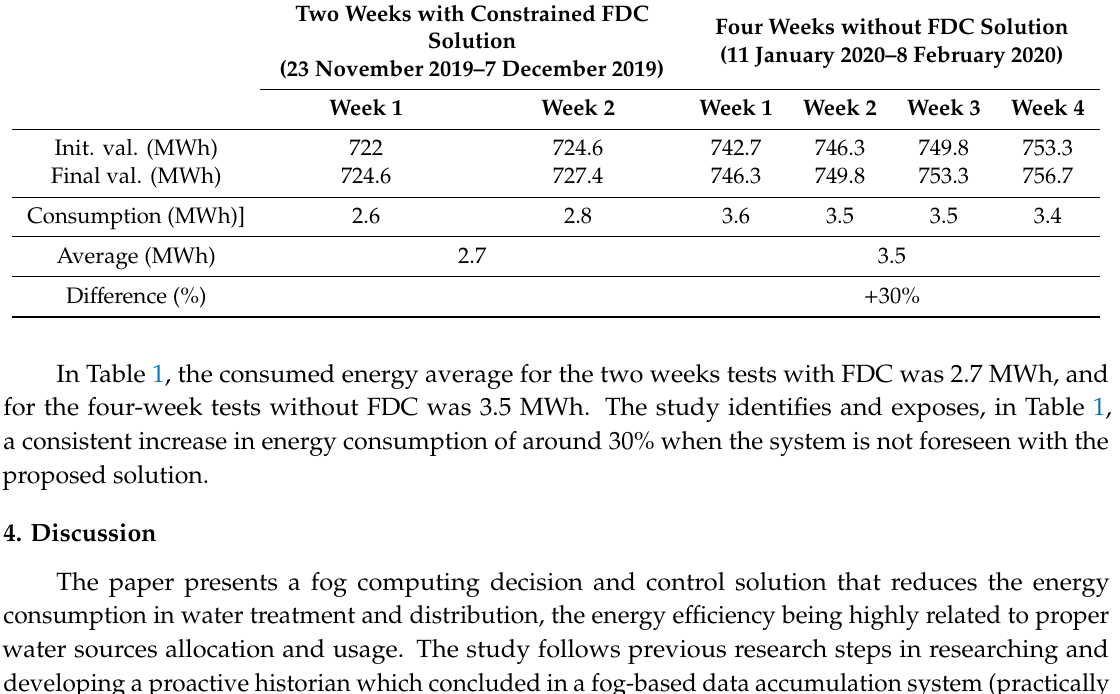
Two Weeks with Constrained FDC